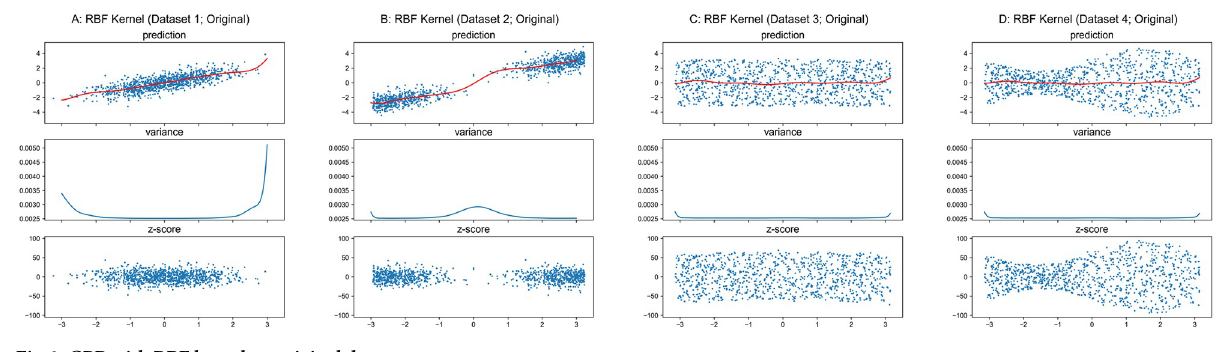
Fig 6. GPR with RBF kernel on original